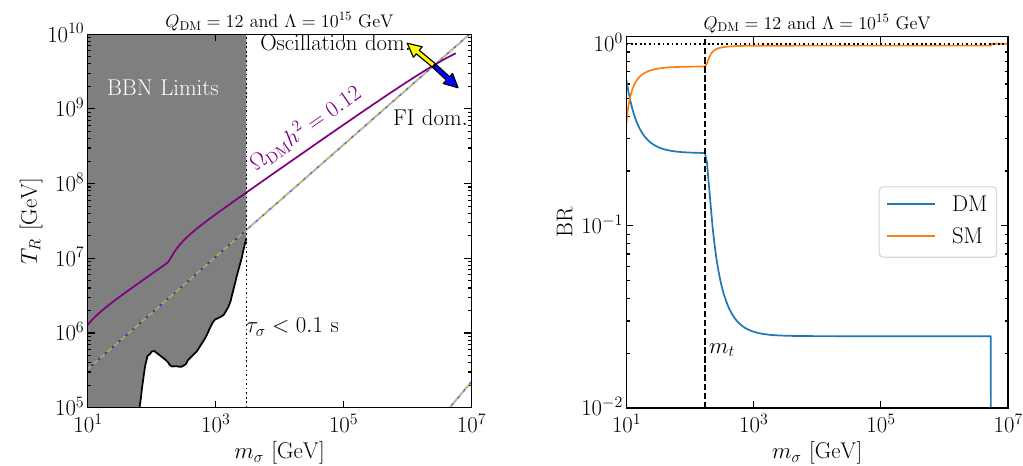
Figure 2 . Left: the BBN constraints (black shaded) on the ( m σ , T R ) plane when there is also a dark Dirac fermion that couples to the flavon field. The purple line shows the points in parameter space that would produce the correct relic density for this dark matter particle. The vertical dotted line is the point where BBN limits are no longer relevant because the flavon decays before BBN begins. The blue and yellow stripped line indicates the transition from oscilation to freeze-in dominated production of flavons, as seen in figure 1. Right: branching ratios for flavon decays into the dark and visible sectors in blue and orange, respectively. For both panels we show the example where Λ = 10 15 GeV and Q χ = 12 that give m χ = 0 . 5 GeV.